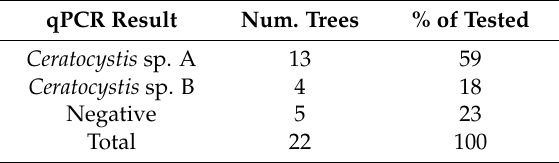
Table 2. Results of quantitative Polymerase Chain Reaction (qPCR) tests on wood from ʻ ō hi ʻ a trees collected in the ‘brown’ canopy state, and thus suspected of having succumbed to ROD (see Table 1).